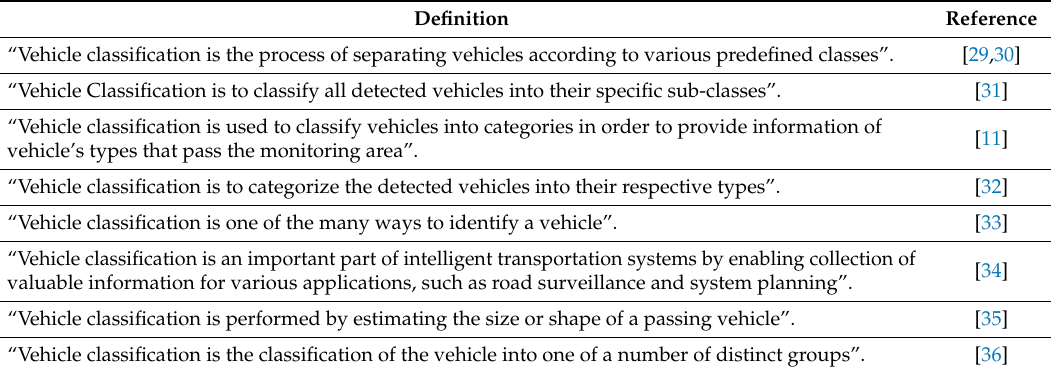
Table 1. A summary of the existing definitions for vehicle classification (VC) phenomenon. Definition